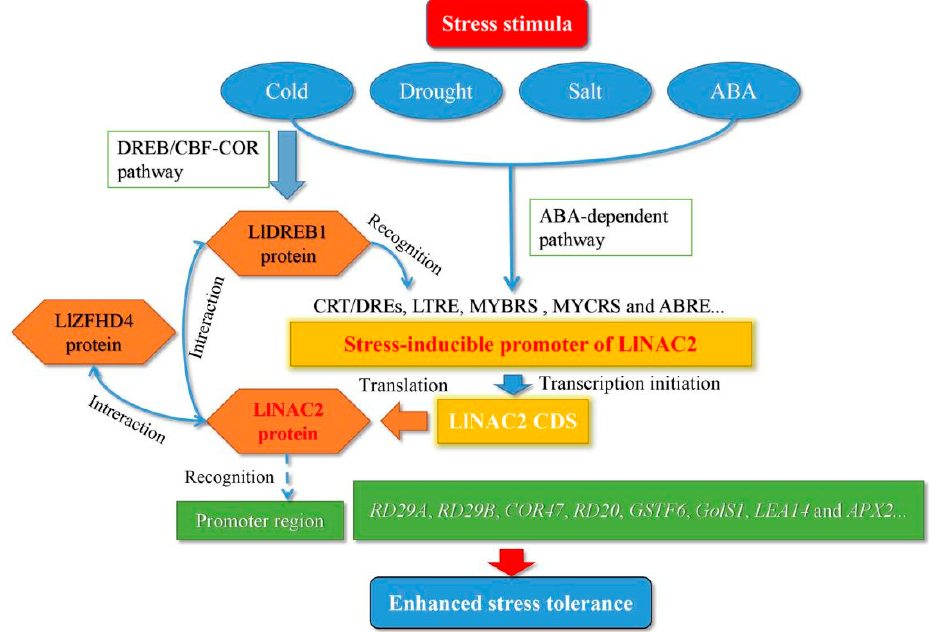
Figure 10. LlNAC2 is involved in both DREB / CBF-COR and ABA-dependent pathways to mediate stress tolerance of the tiger lily.